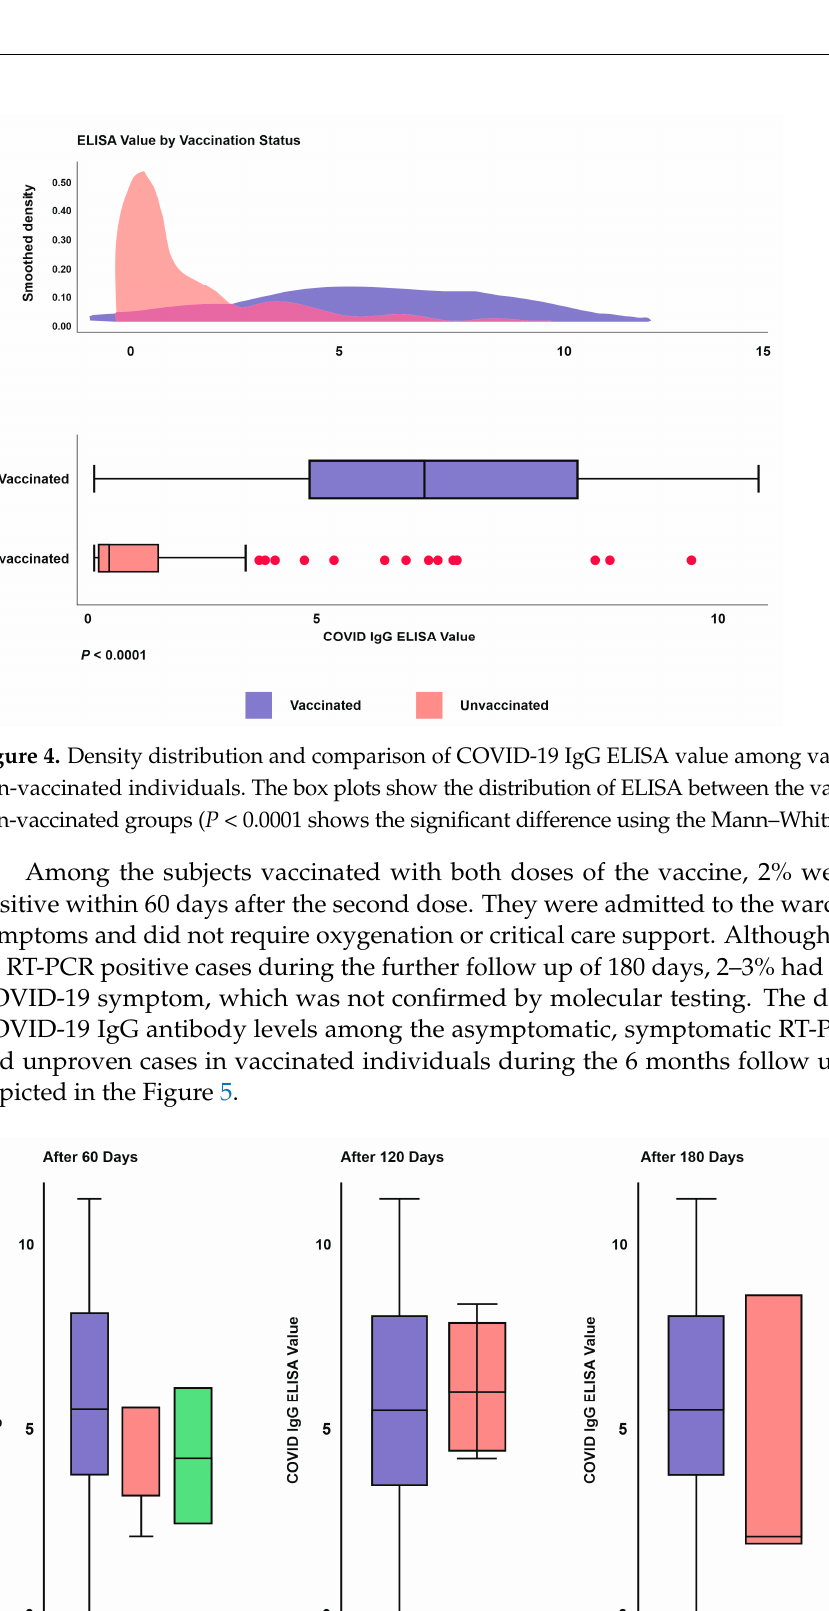
Figure 5. Difference in COVID-19 IgG antibody levels among the symptomatic RT-PCR proven and unproven cases in vaccinated individuals during the 6 months follow up.